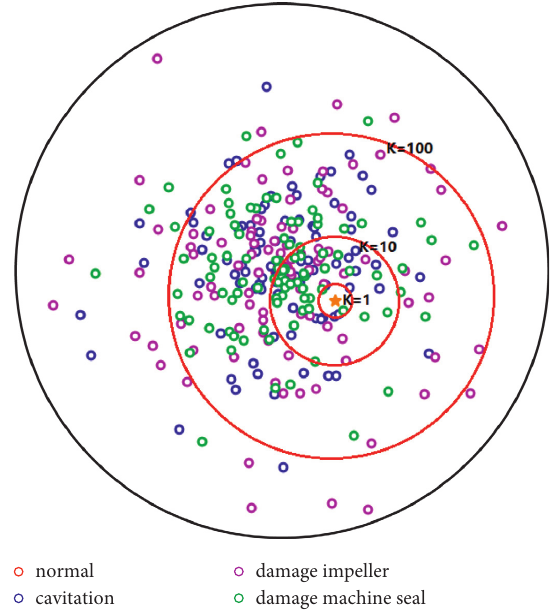
Figure 4: Schematic diagram of sample point distribution and K values.